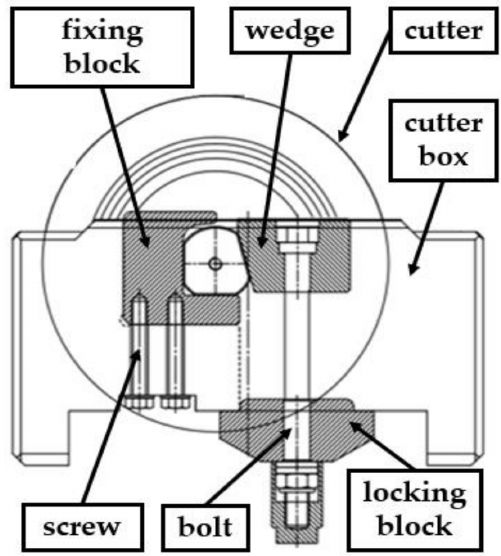
Figure 2. Structure diagram of the traditional cutter system